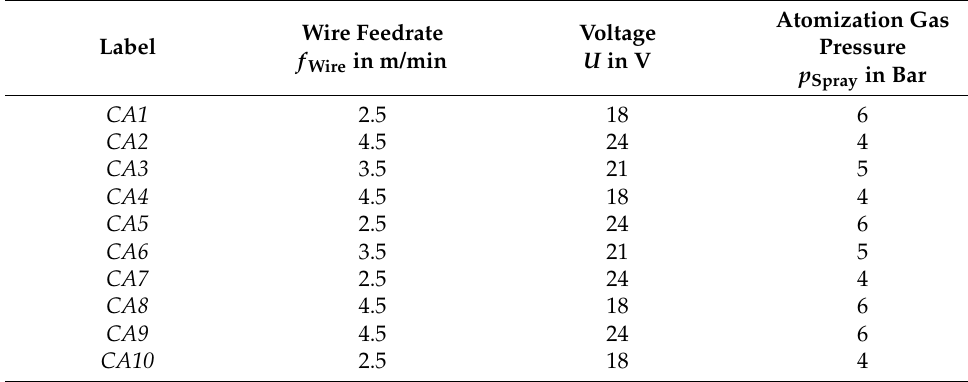
Table 2. Full-factorial plan for the TWAS process.